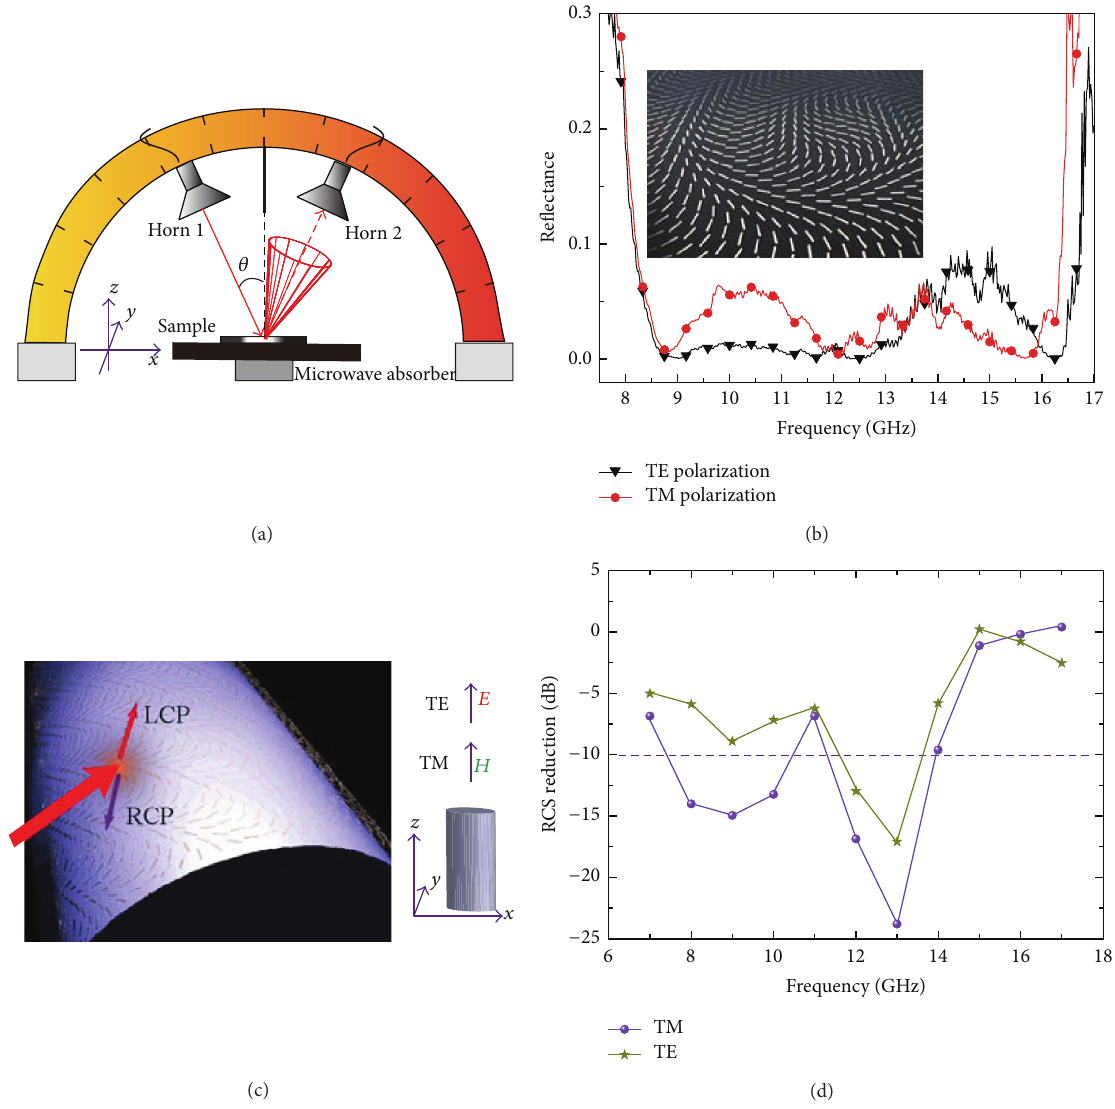
Figure 37: (a) Schematic of the measurement setup. (b) Measured results for both TE polarization and TM polarization. The inset shows the photography of the fabricated sample. (c) Schematic of the spin-orbit conversion in the curved metasurface on a metallic cylinder. The insets show the definitions of TE polarization and TM polarization. (d) Calculated broadband RCS reduction for TE polarization and TM polarization at normal incidence along 𝑦 -direction. Figures are reproduced from